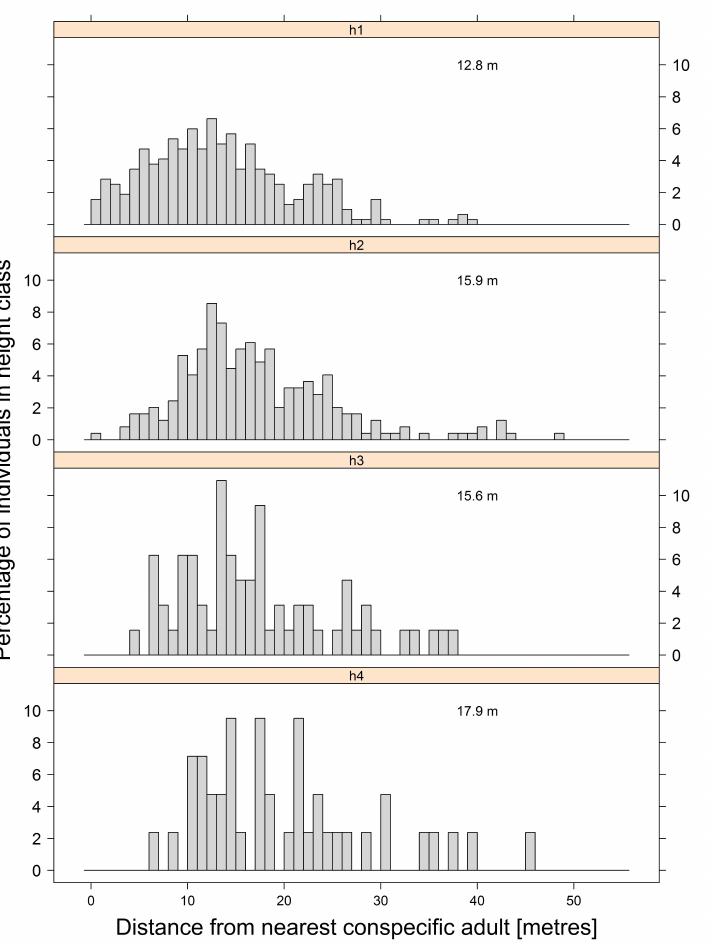
Figure 2. Frequency distributions (percent) of the distance to adult conspecifics for seedlings of V. odorata in four height classes. The median distance between a seedling and the nearest adult tree is also shown.